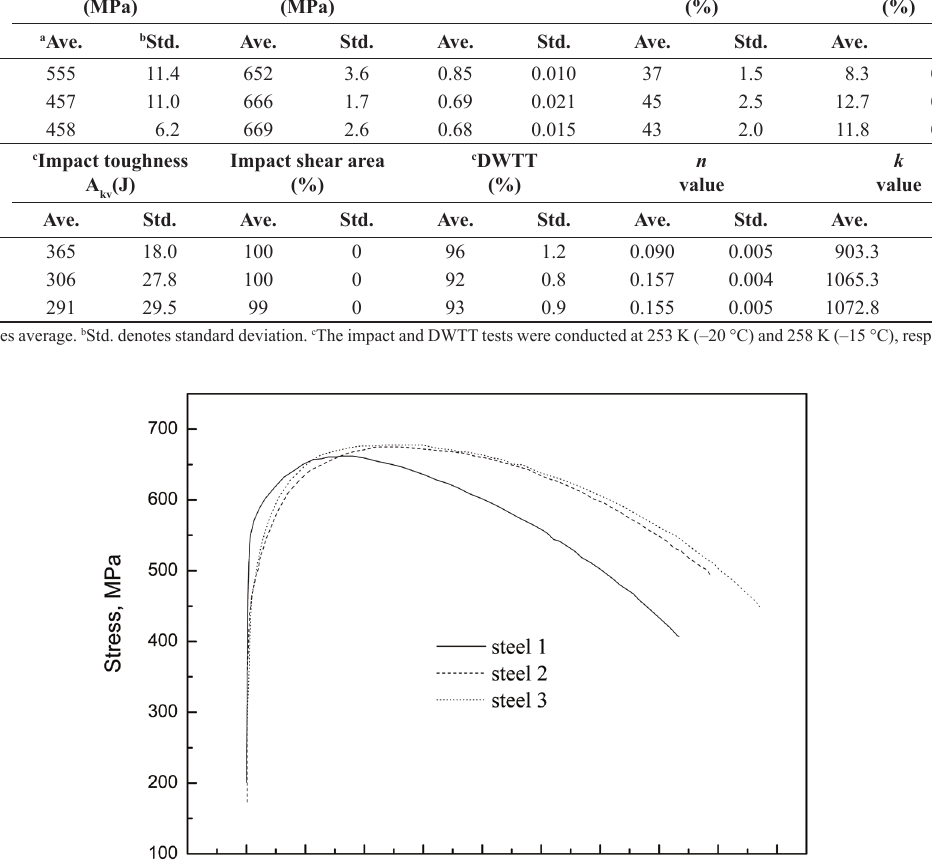
Table 1. Mechanical properties of steel 1, steel 2 and steel 3. Yield strength R t0.5 (MPa)